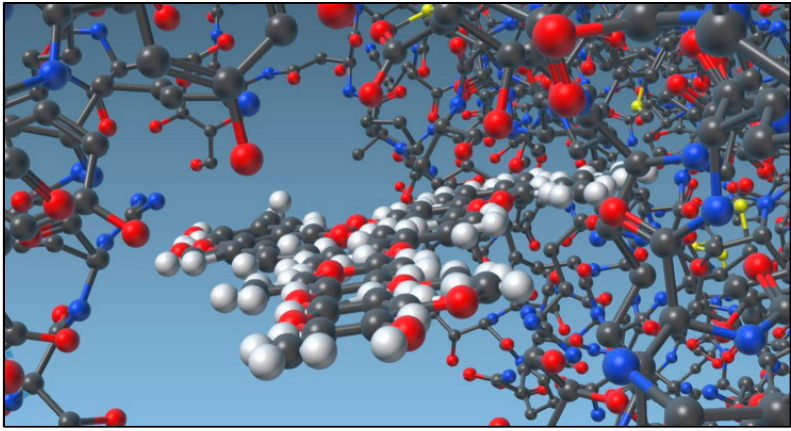
Figure 3. IVM bridging between SARS-CoV-2 (left) and ACE2 receptor (right). Figure adapted from reference [30] with permission from the International Institute of Anticancer Research.